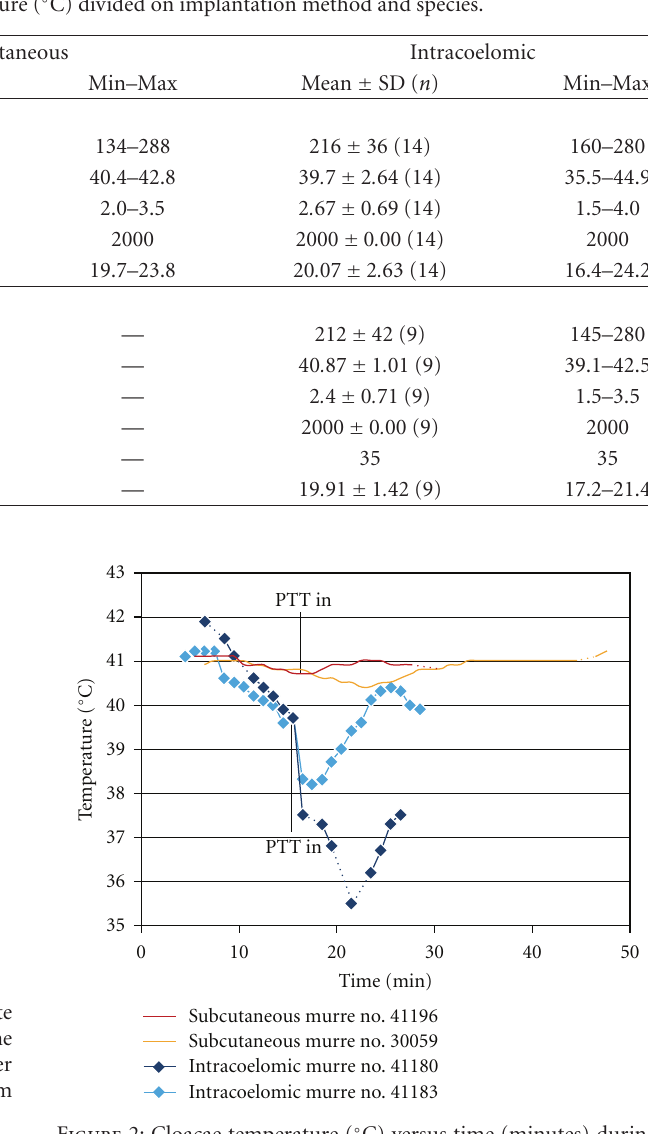
Figure 2: Cloacae temperature ( ◦ C) versus time (minutes) during subcutaneous and intracoelomic PTT murre implantations. Note the di ff erence in CT decrease between subcutaneous and intra- coelomic implantations. Broken lines:data